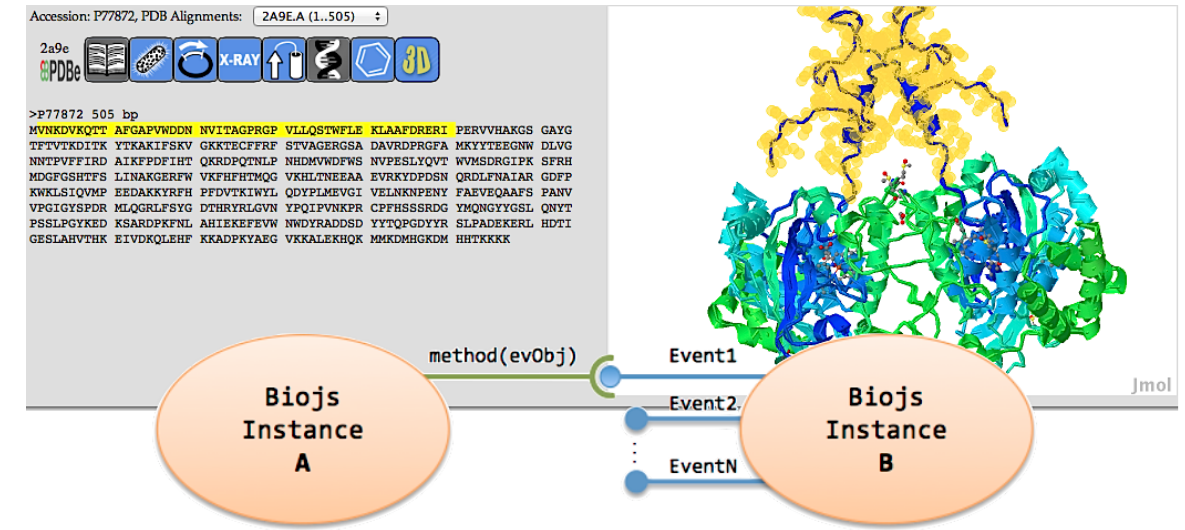
Figure 2. Example of communication between Sequence and Protein3D